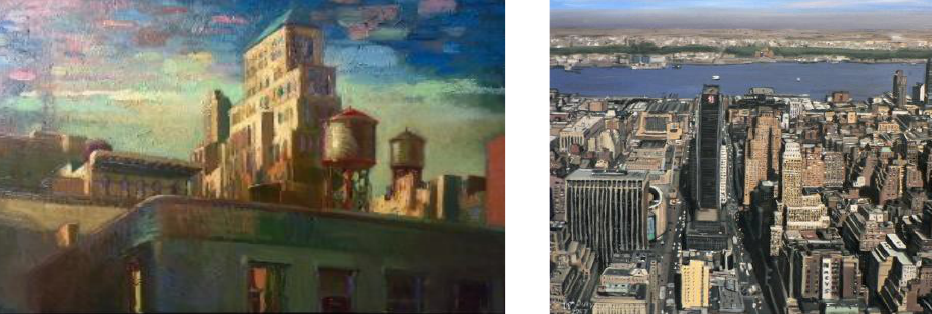
Fig. 24 city sky 2017 oil on panel 24 x 36 inches Fig. 25 Manhattan Skyline from top of Empire State- oil on